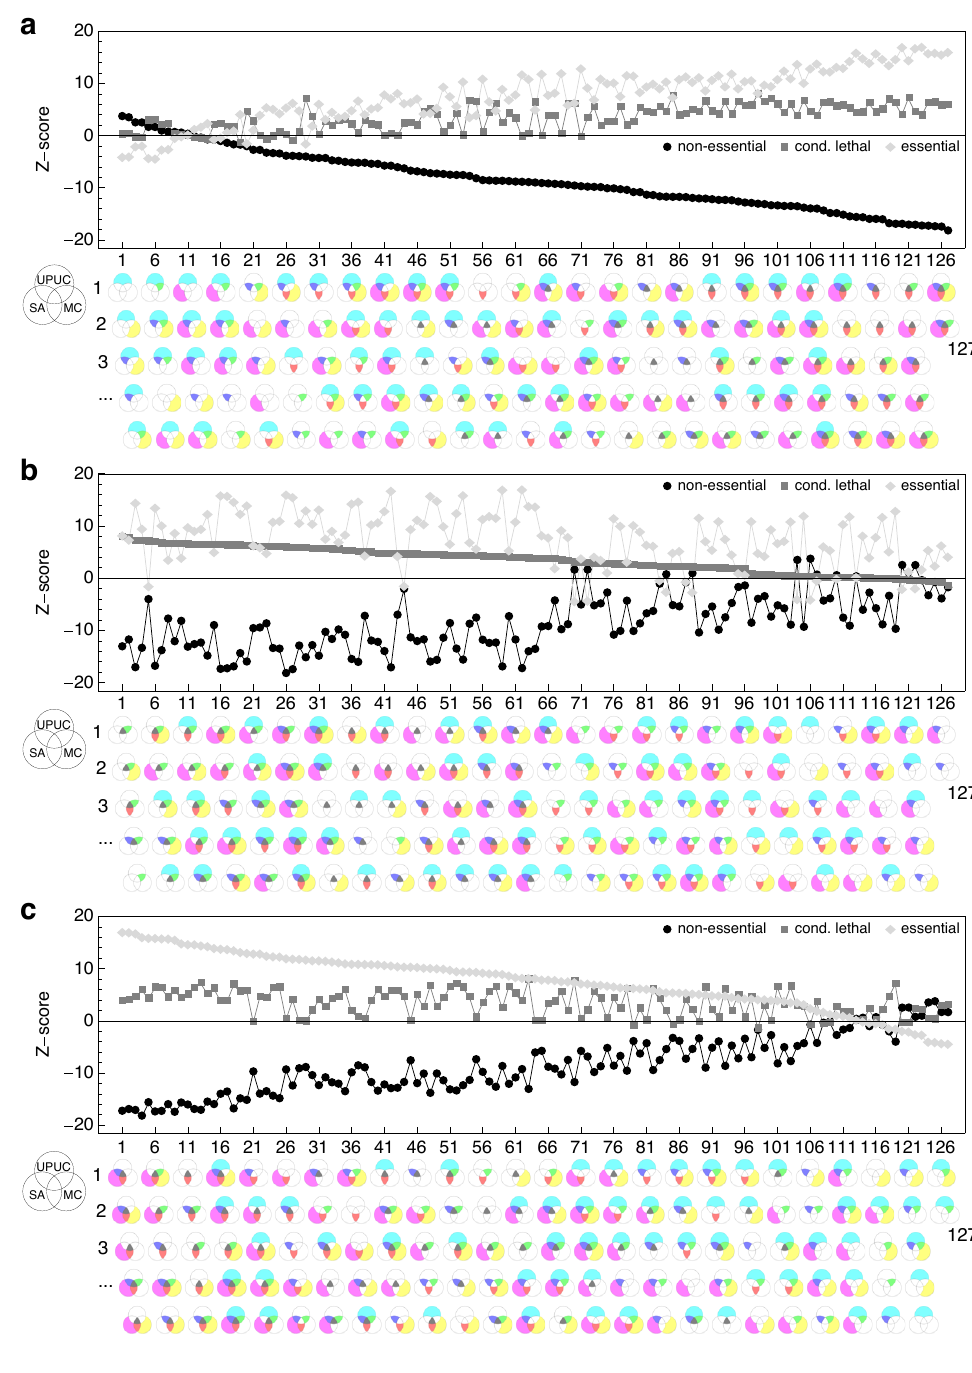
Figure 5. Enrichment of combinatorial reaction category sets for essentiality classes. Combinatorial sets sorted on the basis of ( a ) non-essential , ( b ) conditional lethal and ( c ) essential class enrichment. Venn diagrams [34] on the abscissa indicate each of the 127 nonempty unions and intersections of UPUC (upper circle), SA (lower left circle) and MC (lower right circle), respectively (no set includes less than 13 reactions, the largest combinatorial set includes 332 reactions). For the computation of Z-scores, random distribution of essentiality classes among the Venn intersections and unions was used as the underlying null